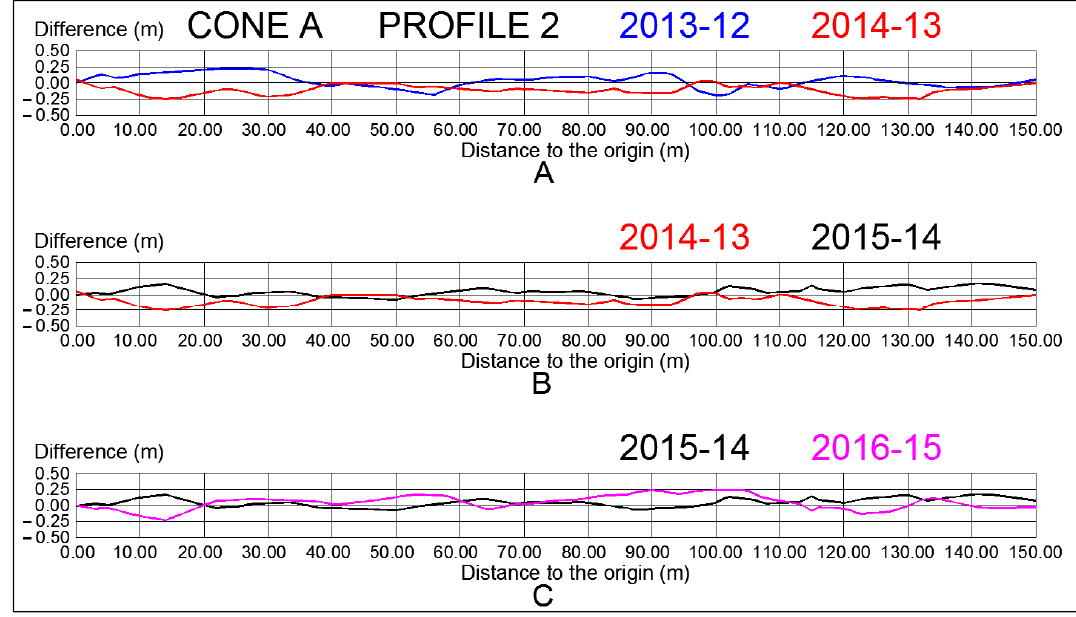
Figure 7. Representation profile 2 of Cone A by groups of three years: (A) 2013–12 and 2014–13. (B)